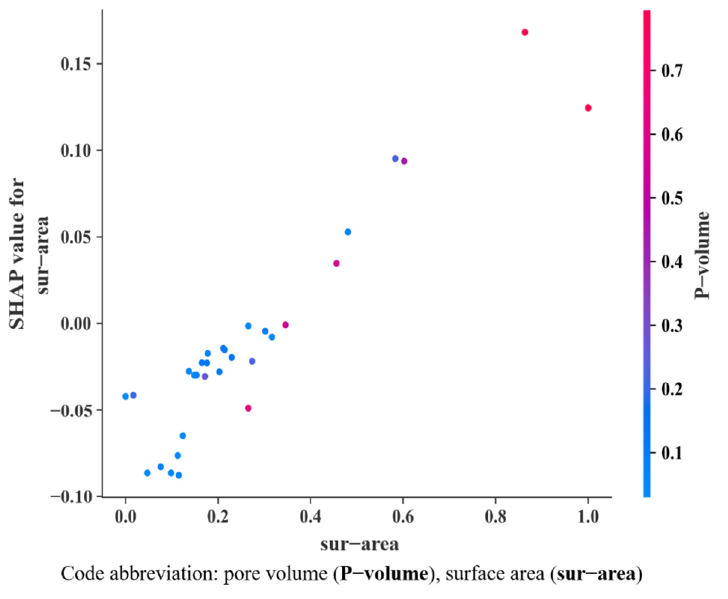
Figure 9. SHAP dependence plot for visualization of the interaction between sur − area and P − vol- ume .